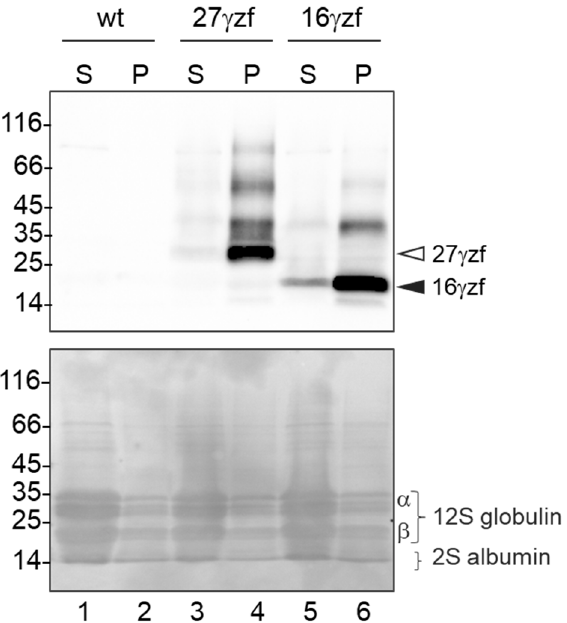
Figure 3. 16 γ zf PB-like structures visualized by EM are mainly insoluble in salt buffer, similar to 27 γ zf PBs. Dry seeds from wt, 27 γ zf, or 16 γ zf plants were ground and homogenized in saline buffer without reducing agents or detergent. Soluble (S) and insoluble (P) fractions were separated by centrifugation. Both (S) and (P) fractions were analyzed by SDS-PAGE followed by protein blot. Top panel: anti-FLAG antibodies. The positions of 27 γ zf and 16 γ zf monomers are indicated by the empty and the black arrowheads, respectively. Bottom panel: Ponceau S total protein staining. The positions of the Arabidopsis endogenous seed storage proteins 12S globulins ( α and β subunits) and 2S albumins are indicated. Numbers on the left indicate the position and size (kDa) of molecular mass markers.